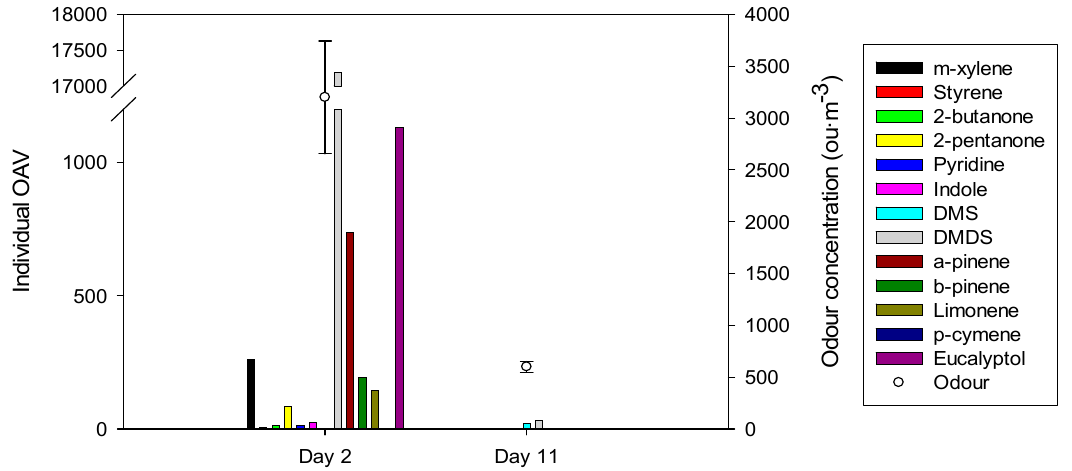
Figure 6. Odour concentration and individual odour activity value (OAV i ) > 1 determined for the gaseous samples obtained during the thermophilic phase (day 2) and the mesophilic phase (day 11) of the conventional sewage sludge composting process.